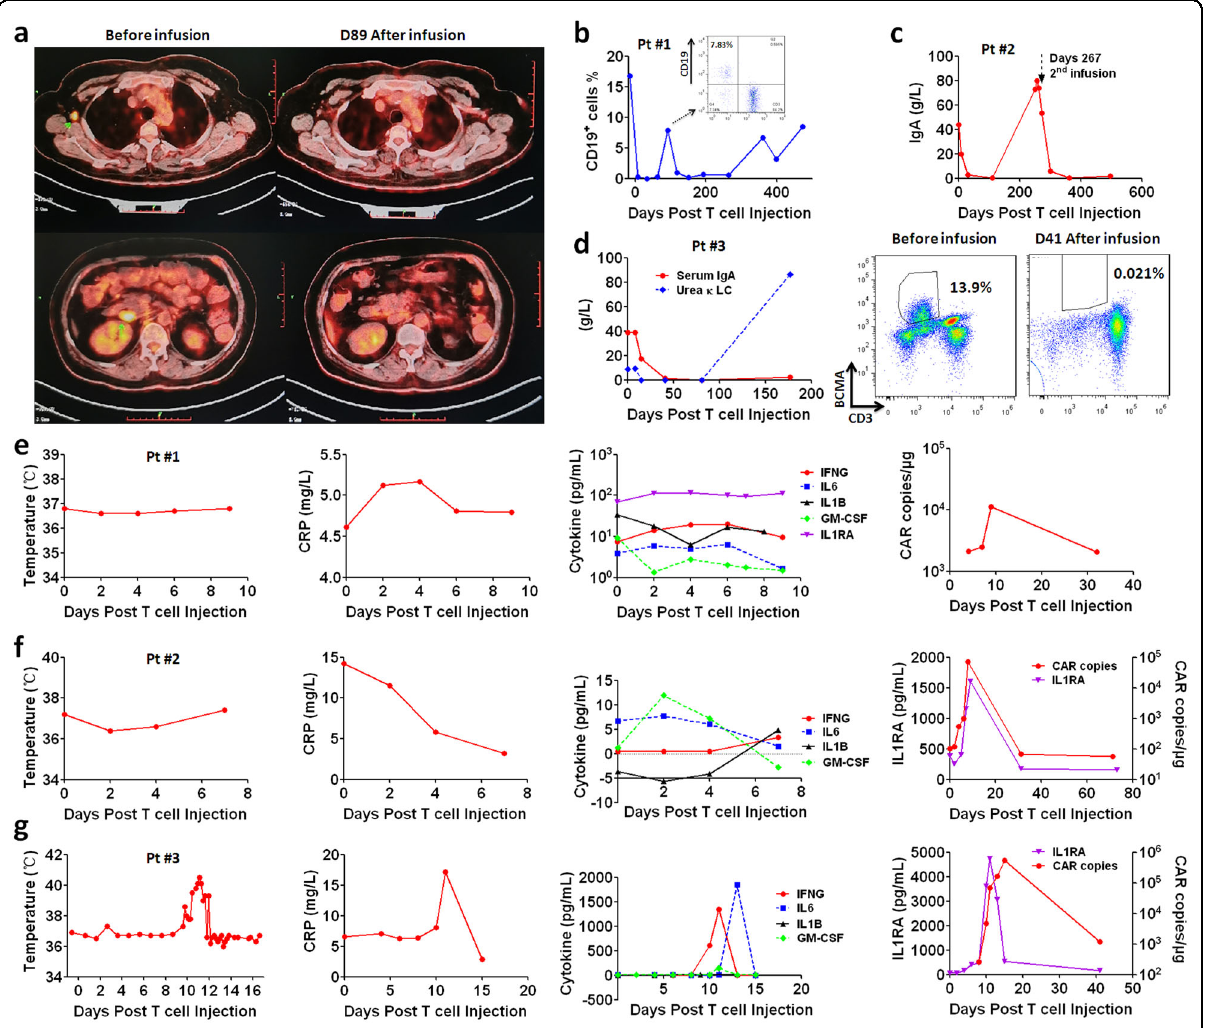
Fig. 4 Complete response was achieved in all three patients after treatment with CRISPR-edited anti-CD19 or anti-BCMA CART-aIL6/IL1RA with GM-CSF/TCR KO. a PET-CT imaging of primary tumor sites in right armpit and retroperitoneum in patient #1 before and after treatment, as pointed by the green arrow. b Frequencies of CD19 + B cells in the blood of patient #1 before and after infusion. c Changes of serum IgA in patient #2. Patient was given the 2nd infusion of CART co-expressing IL6 and IL1 blockers with GM-CSF/TCR WT when IgA bounced back to aberrant level. d Changes of serum IgA and Urea κ Light Chain (LC) in patient #3 (left panel), and frequencies of BCMA + cells in the blood before and after infusion (right panel). e – g Changes of body temperature, cytokines (CRP C-reactive protein), and CAR vector copes in patient #1 ( e ), patient #2 ( f ), patient #3 ( g ) treated with CRISPR-edited anti-CD19 or anti-BCMA CART-aIL6/IL1RA with GM-CSF/TCR